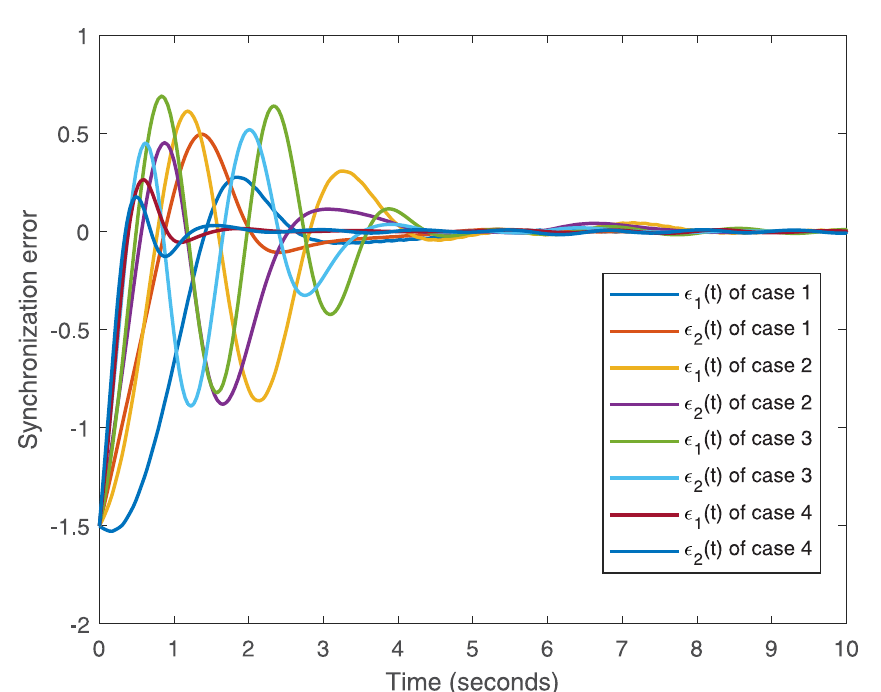
Fig 4. System behavior error under ϖ ( t ) 6¼ 0 with the control input for the cases 1–4.